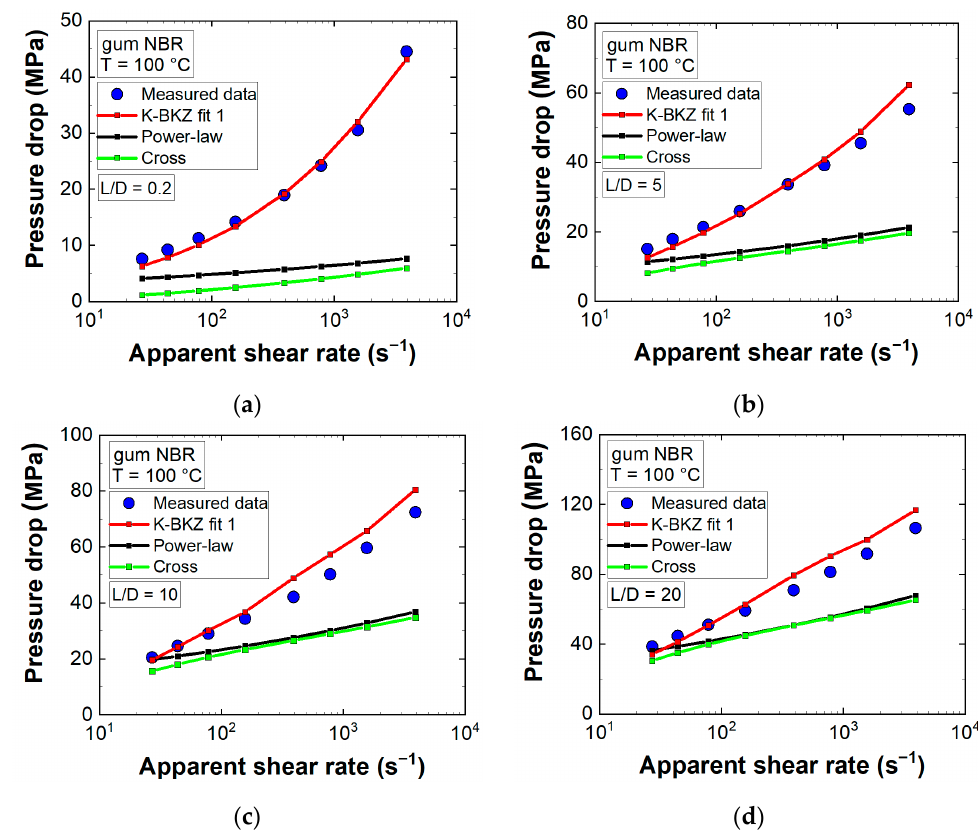
Figure 9. Measured pressure data compared to CFD simulation results of the ( a ) tapered orifice die (L/D = 0.2/1); ( b ) abrupt capillary die with a length-to-diameter (L/D) ratio of 5/1; ( c ) abrupt capillary die with L/D = 10/1; ( d ) abrupt capillary die with L/D = 20/1.